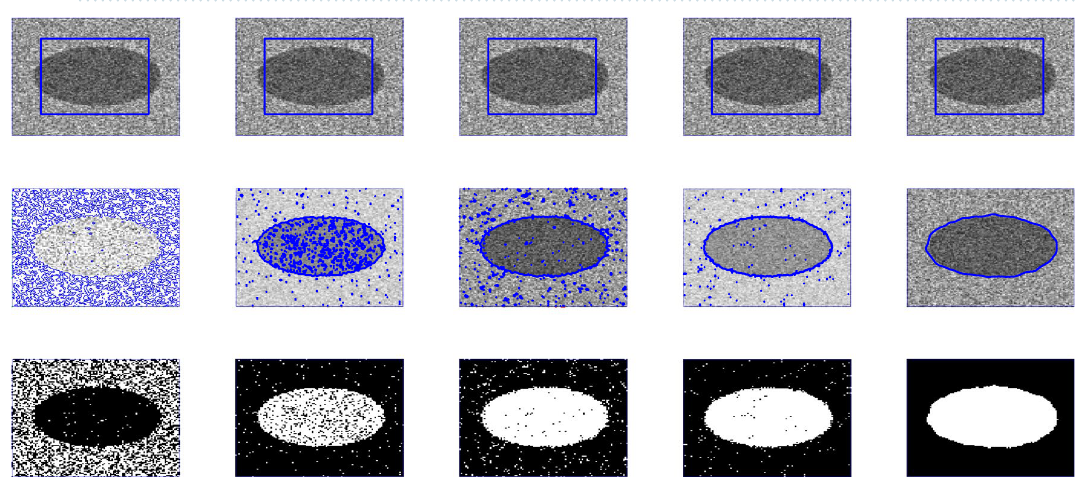
1 Figure 4. This image is taken from the Berkeley’s data set . First row shows the given image and the zero level set initialization, the second row shows the segmentation contour and the last row denotes the binary image resulting from the reconstruction of each method involved in the comparison. First, second, third and fourth columns are the segmentation results of Wu et al. 24 , Li et al. 15 , Wu et al. 12 and Krinidis et al. 31 , respectively. The fifth column illustrates the result of proposed model with p = 0.5 , µ =0.7, σ =3, with speckle noise =